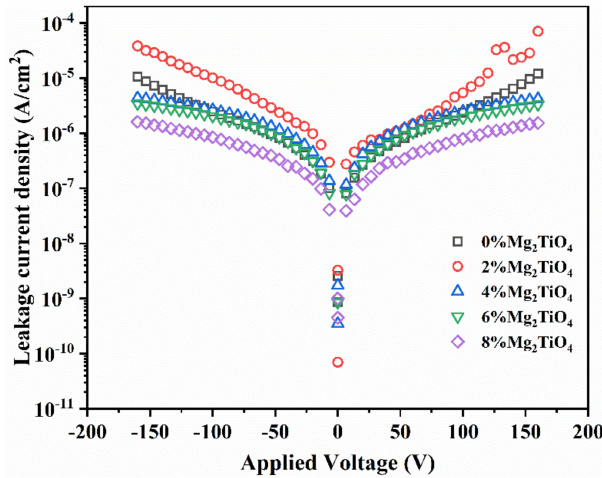
Figure 6. The leakage current density of x% Mg 2 TiO 4 -CSZT thin films as a function of the applied bias voltage at room